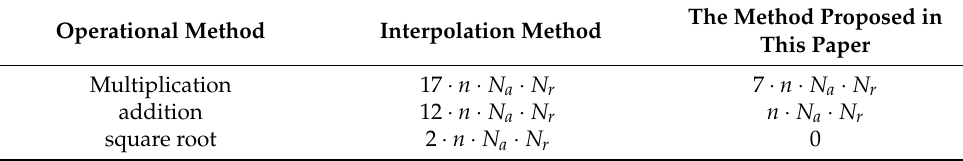
Table 2. Computational cost